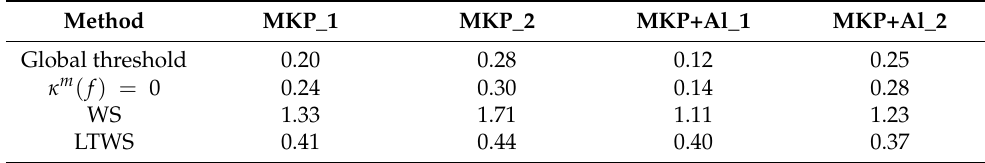
Table 2. Samples porosities (%) calculated from the binary images shown in Figure